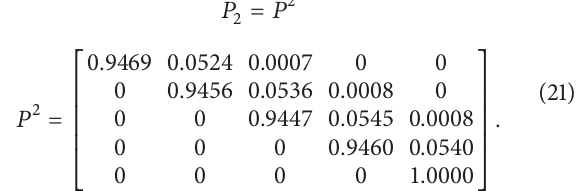
Figure 8: New York Department of Transportation condition state data.